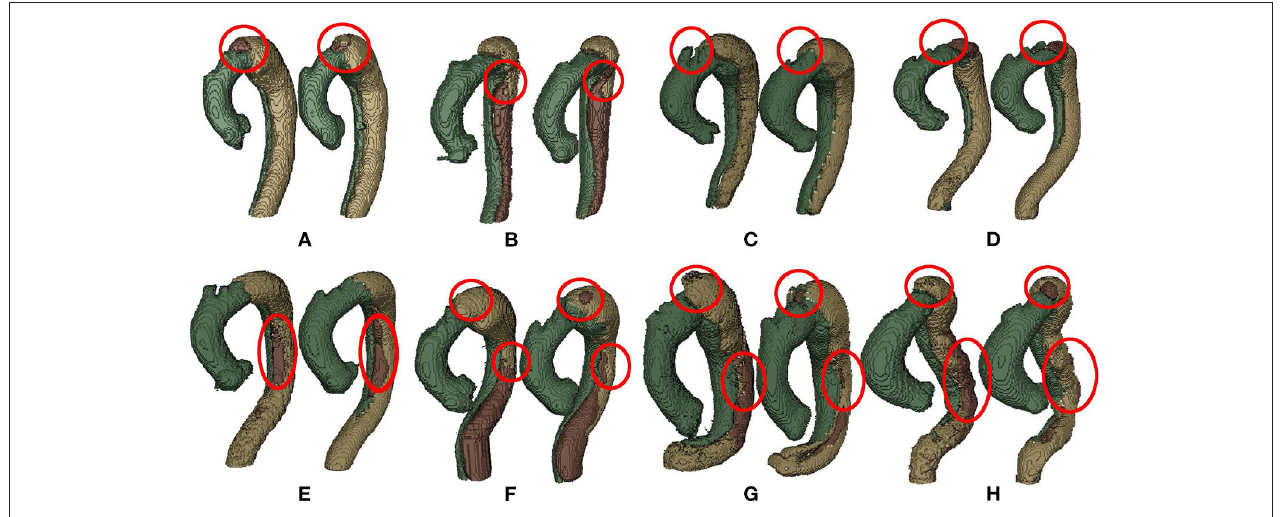
FIGURE 5 | Examples of good segmentation results (A,B,E,F) with its corresponding ground truth (C,D,G,H) . Best viewed in color.